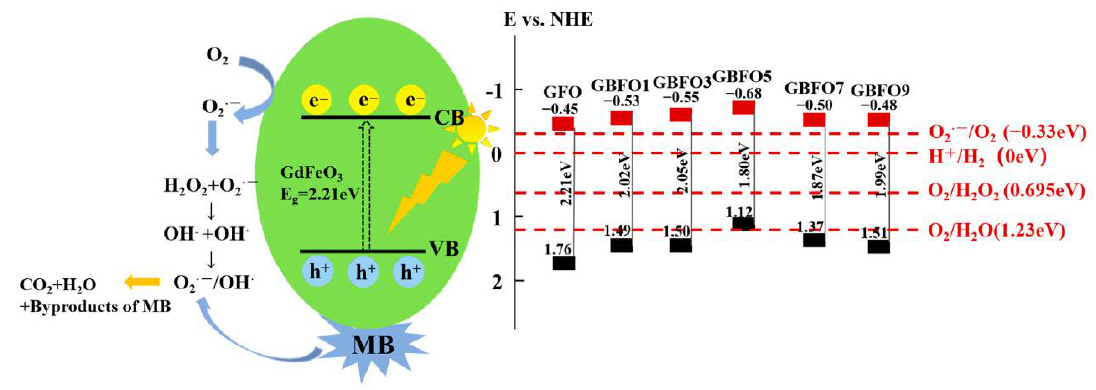
Compared with GFO, the conduction band of Bi-doped samples was more negative, making it easier to generate superoxide anions to participate in the reactions.